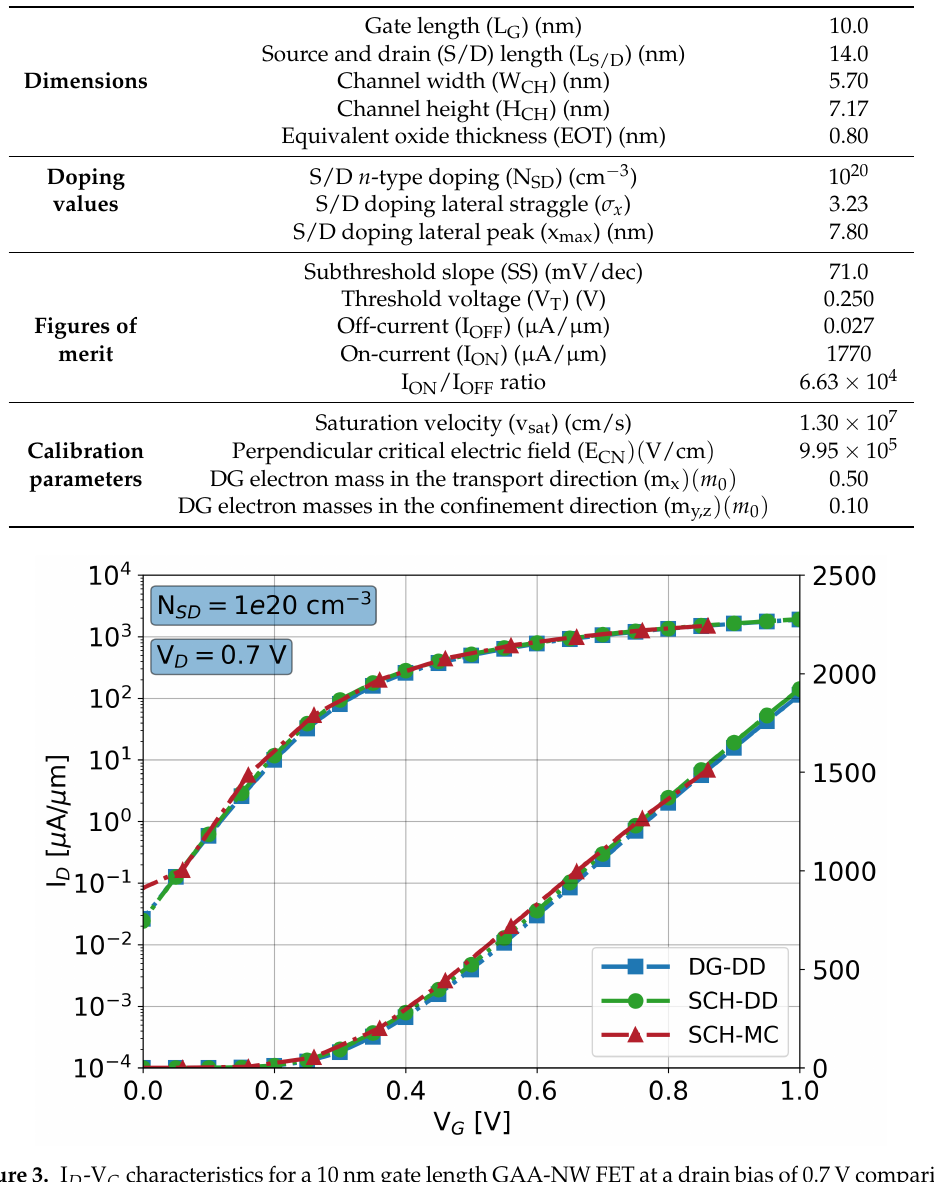
Figure 3. I D -V G characteristics for a 10 nm gate length GAA-NW FET at a drain bias of 0.7 V comparing simulations results from density-gradient quantum-corrected drift-diffusion simulations (DG-DD), Schrödinger quantum-corrected drift-diffusion simulations (SCH-DD) and SCH-MC. The maximum source/drain Gaussian doping has been set to 10 20 cm − 3